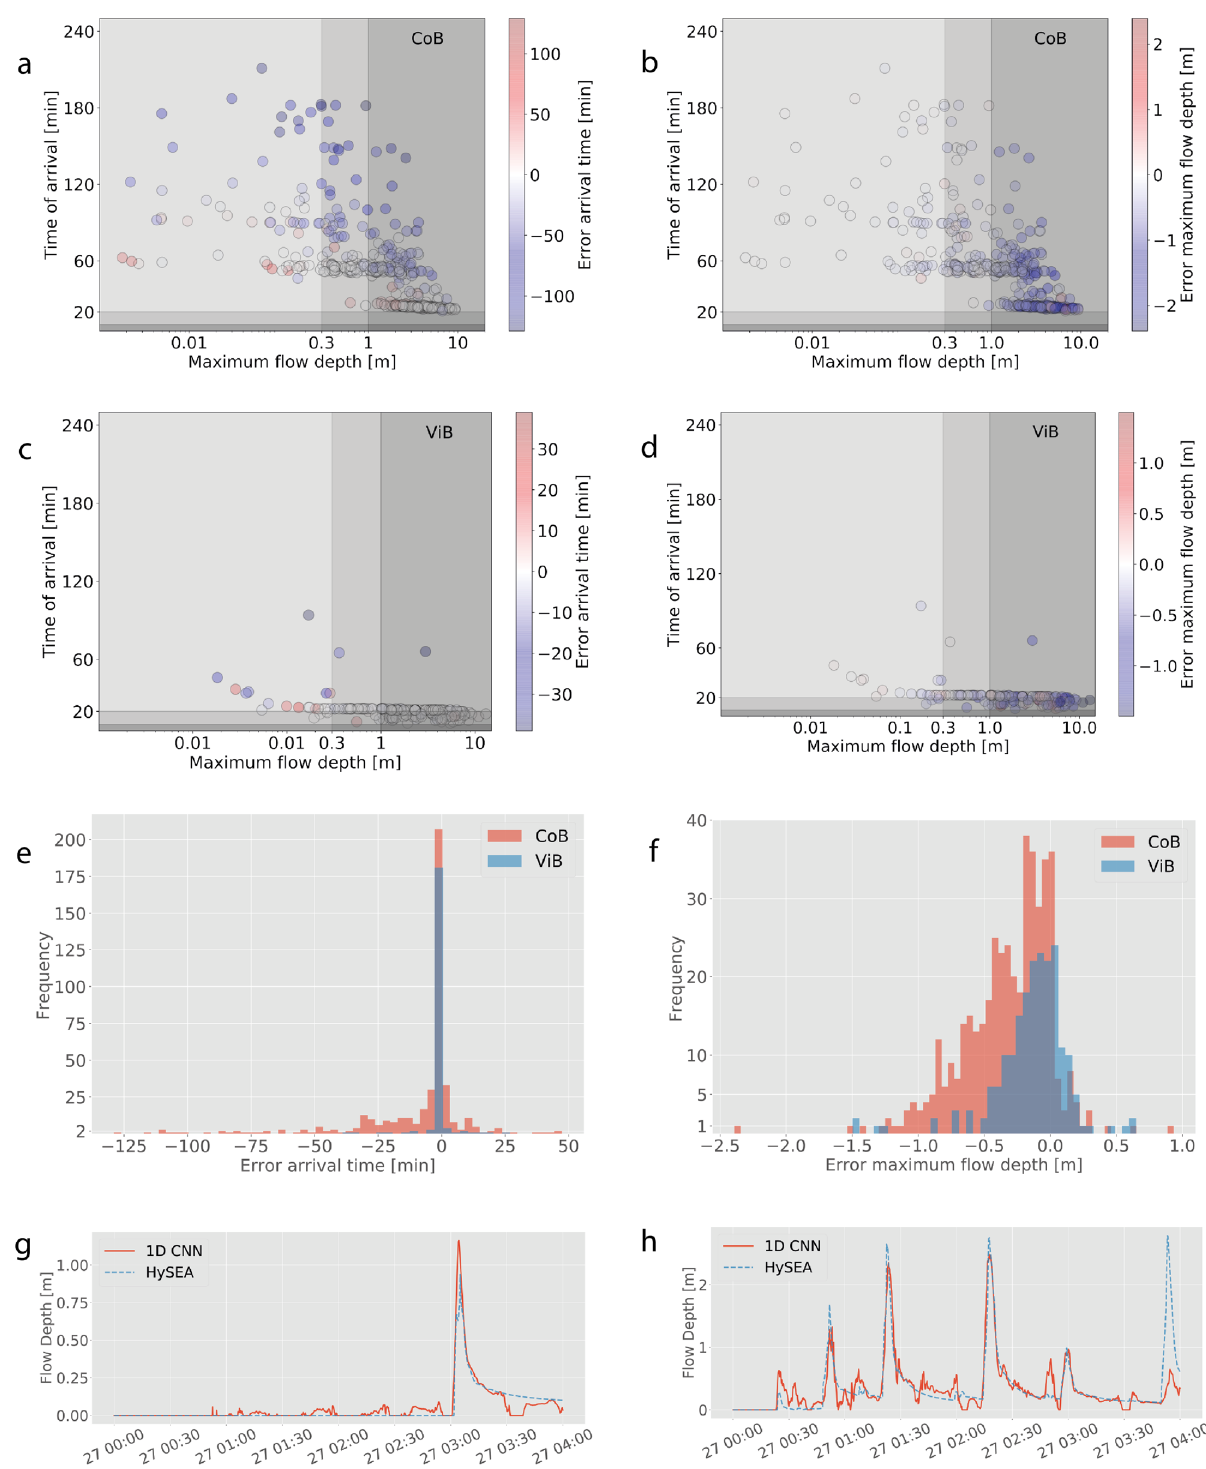
Figure 5. Error in arrival time E t (left column) and maximum flow depth E d for Coquimbo (CoB, top row) y Viña del Mar (ViB, second row). In ( a–d ) warmer colors indicate the NNM under estimates the hazard. ( e, f ) The histograms of each error among all cases. ( g, h ) The time series that lead to the maximum error, where the full forward model using Tsunami-HySEA is shown as dashed blue lines, and the NNM prediction in light red. ( g ) ViB, h)